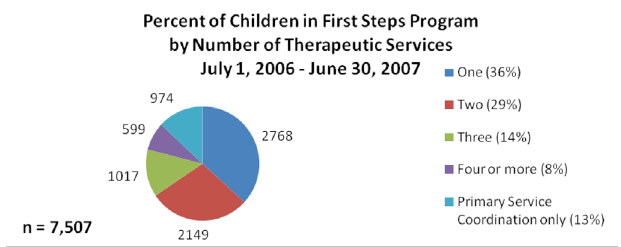
Figure 1 – Source - Kentucky Part C (First Steps) Annual Performance Report (FFY 2006); Monitoring